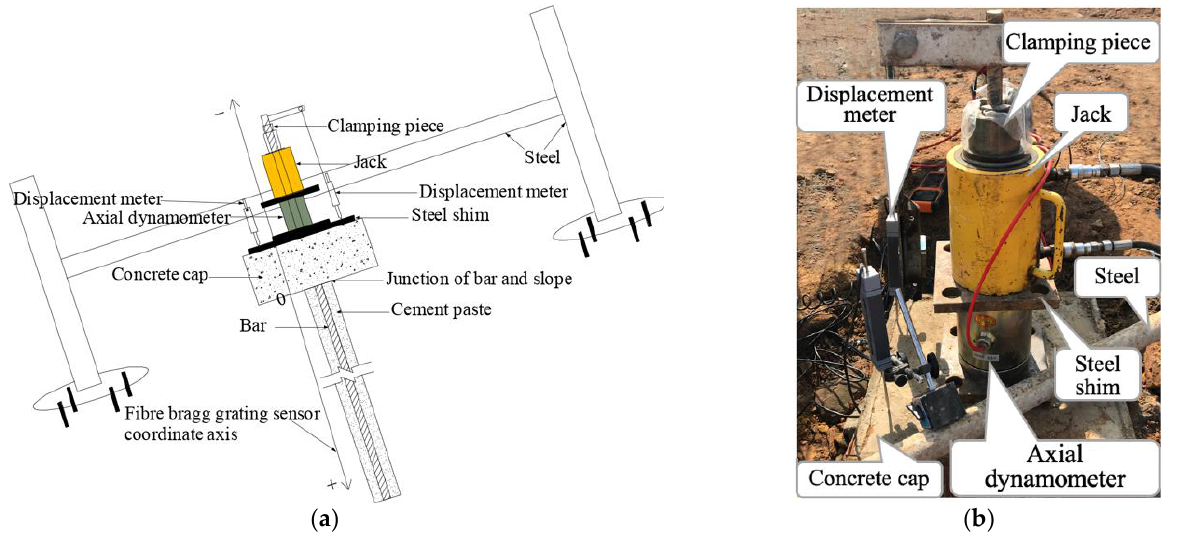
Figure 6. Test device. ( a ) Schematic diagram of the testing device ( b ) Field drawing of the testing